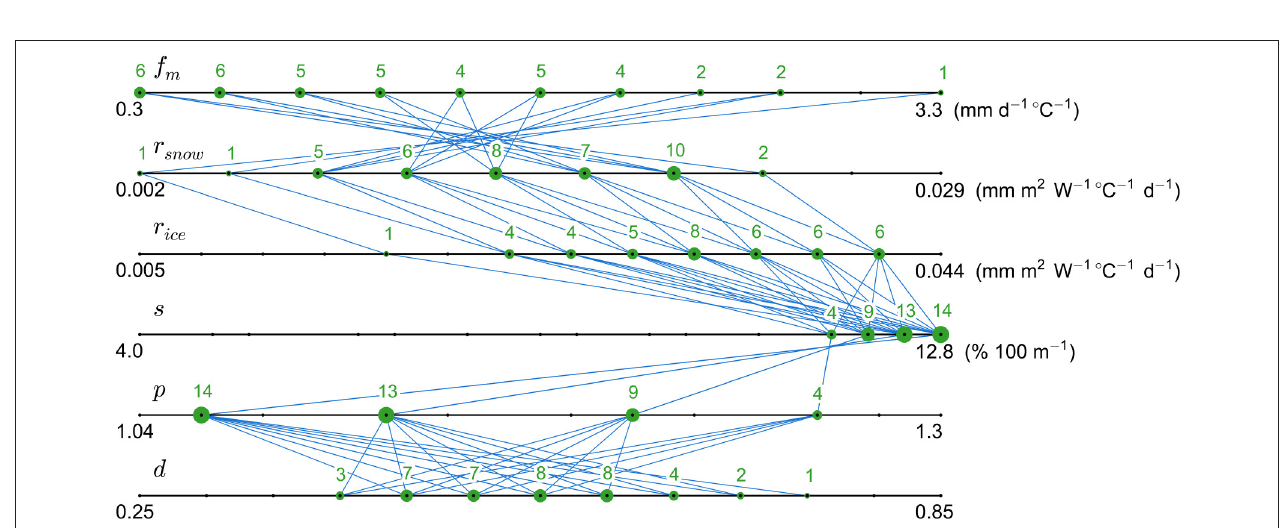
FIGURE 7 | Parameter combinations of the 40 best calibration runs superimposed on the searched parameter space. f m is the melt factor, r snow / ice are the radiation factors of snow and ice, s is the precipitation gradient, and p and d are the precipitation and moraine debris melt reduction factors. Numbers on the left and right sides indicate the end members of the parameter space, including units. Small black dots on the lines show the parameter values tested. Blue lines connect the successful parameter combinations. The green points and their annotations indicate the number of successful combinations crossing through a particular parameter value. Precipitation gradients > 12.8% 100 m –1 caused implausibly low precipitation at the glacier terminus and thus were not accepted.